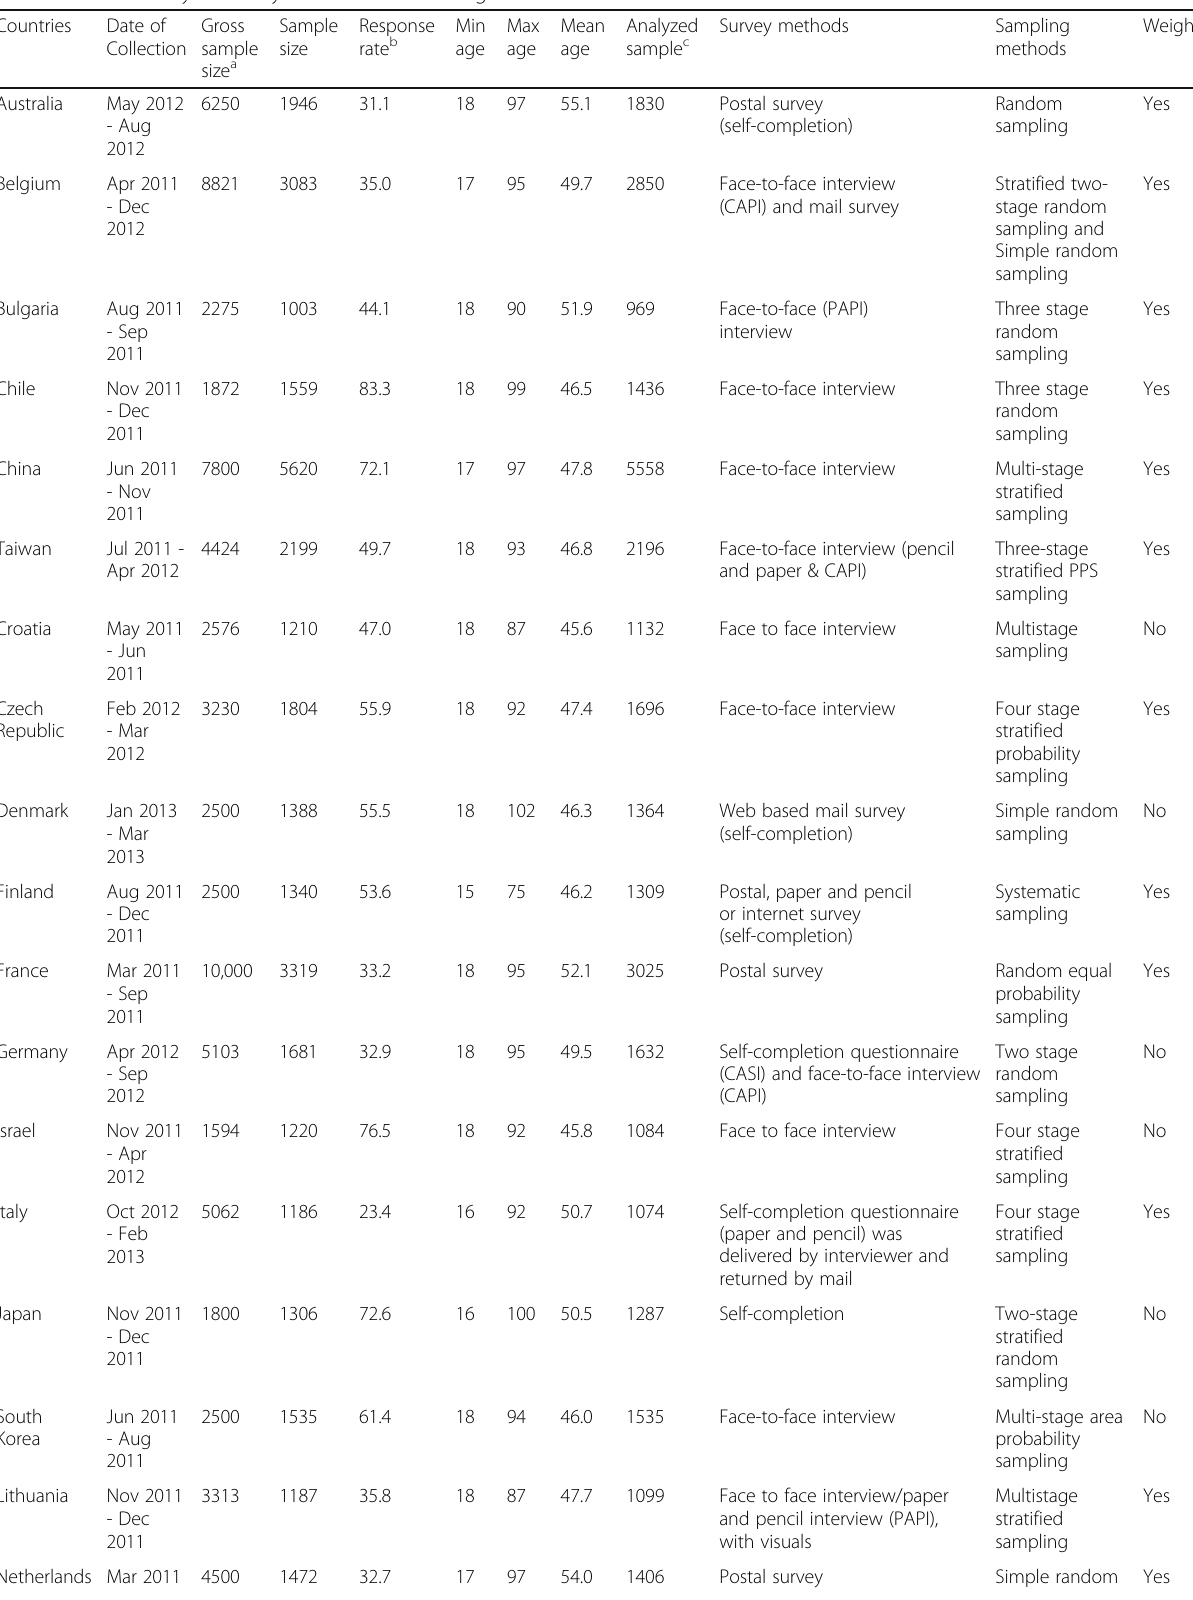
Table 1 Social survey summary of each of the 32 target countries